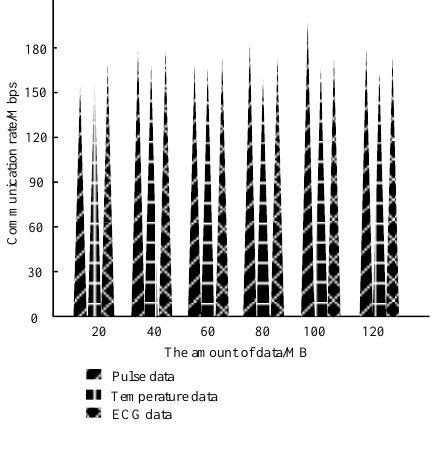
Figure 7. System communication